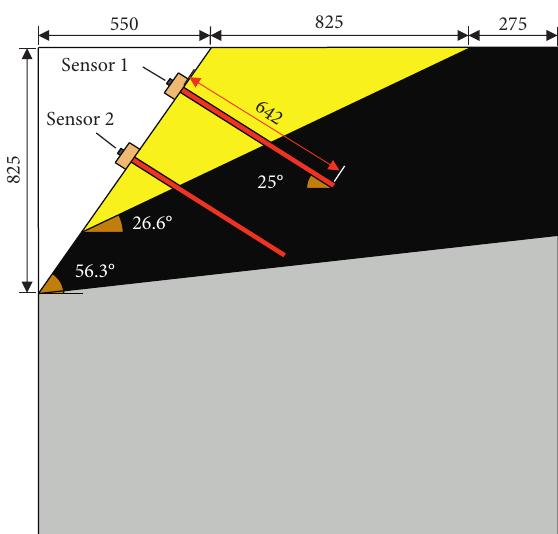
Figure 7: Schematic diagram showing the sliding force sensor.